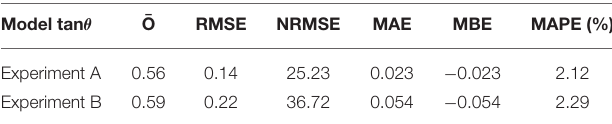
TABLE 3 | Error statistics of flame tilt angle tan θ as a function of Equation 13 for Experiment A and Equation 14 for Experiment